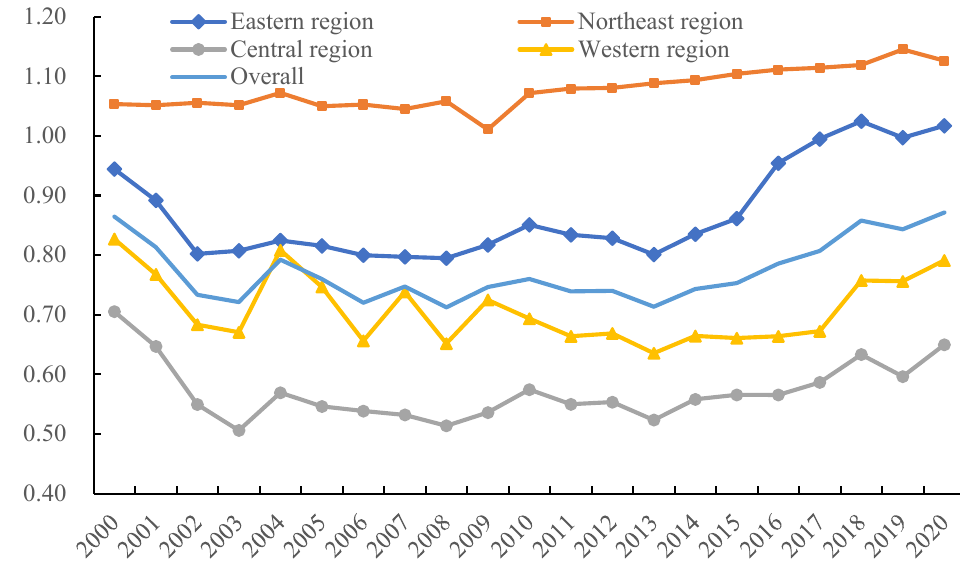
Figure 3. Evolution of AEE in China and four regions from 2000 to 2020.